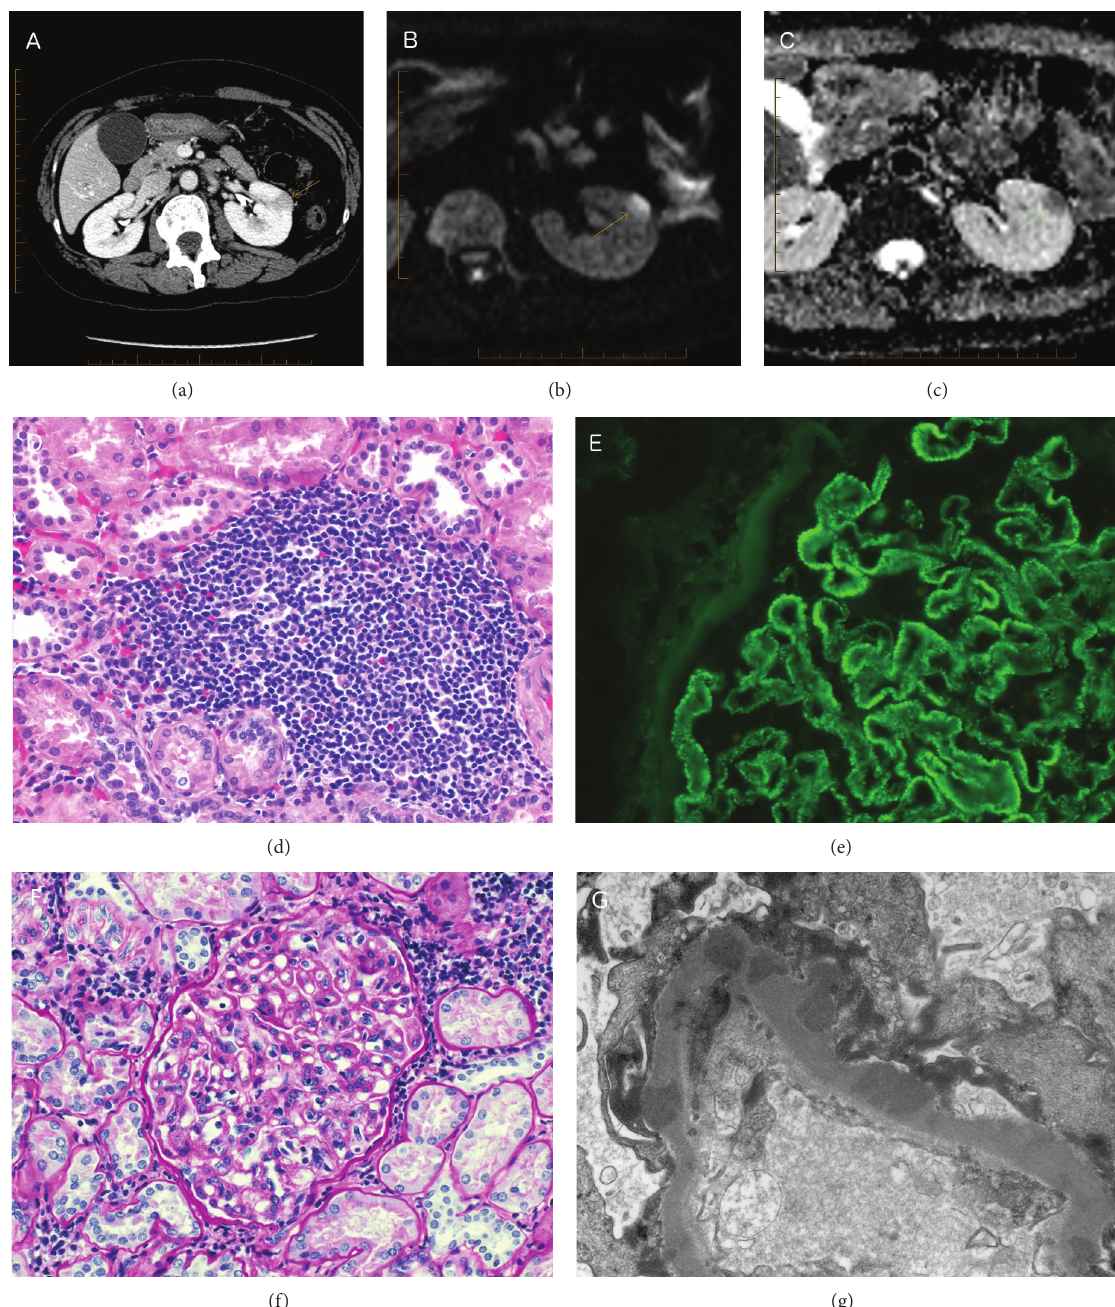
Figure 1: Radiologic and pathologic presentation of the renal lesion. (a) CT scan image showing a homogeneous, enhancing left renal lesion. (b) Diffusion renal magnetic resonance imaging (MRI) image of the same left renal lesion. (c) Apparent diffusion coefficient (ADC) MRI image. (d) Light microscopy with periodic acid-Schiff staining showing a lymphocytic infiltration. (e) Granular positivity of C1q on the glomerular basement membrane by immunofluorescence. (f) Higher magnification of endocapillary hypercellularity. (g) Electronic microscopy showing subepithelial deposits on the glomerular basal